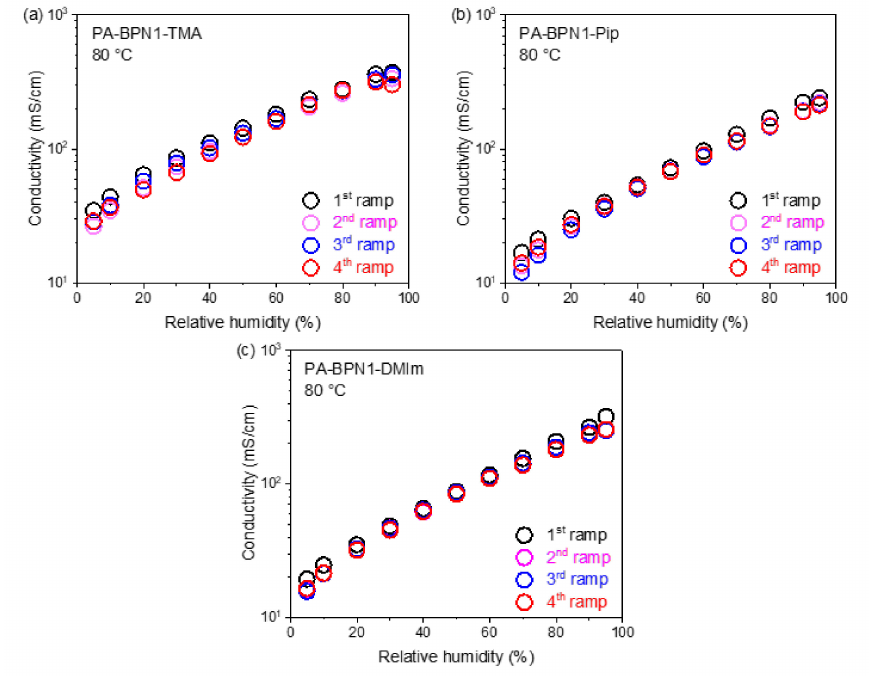
Figure 4. In-plane proton conductivity of ( a ) PA-BPN1-TMA; ( b ) PA-BPN1-Pip; and ( c ) PA-BPN1-DMIm at 80 ◦ C under four successive relative humidity (RH) ramps ranging from 5% to 95%.